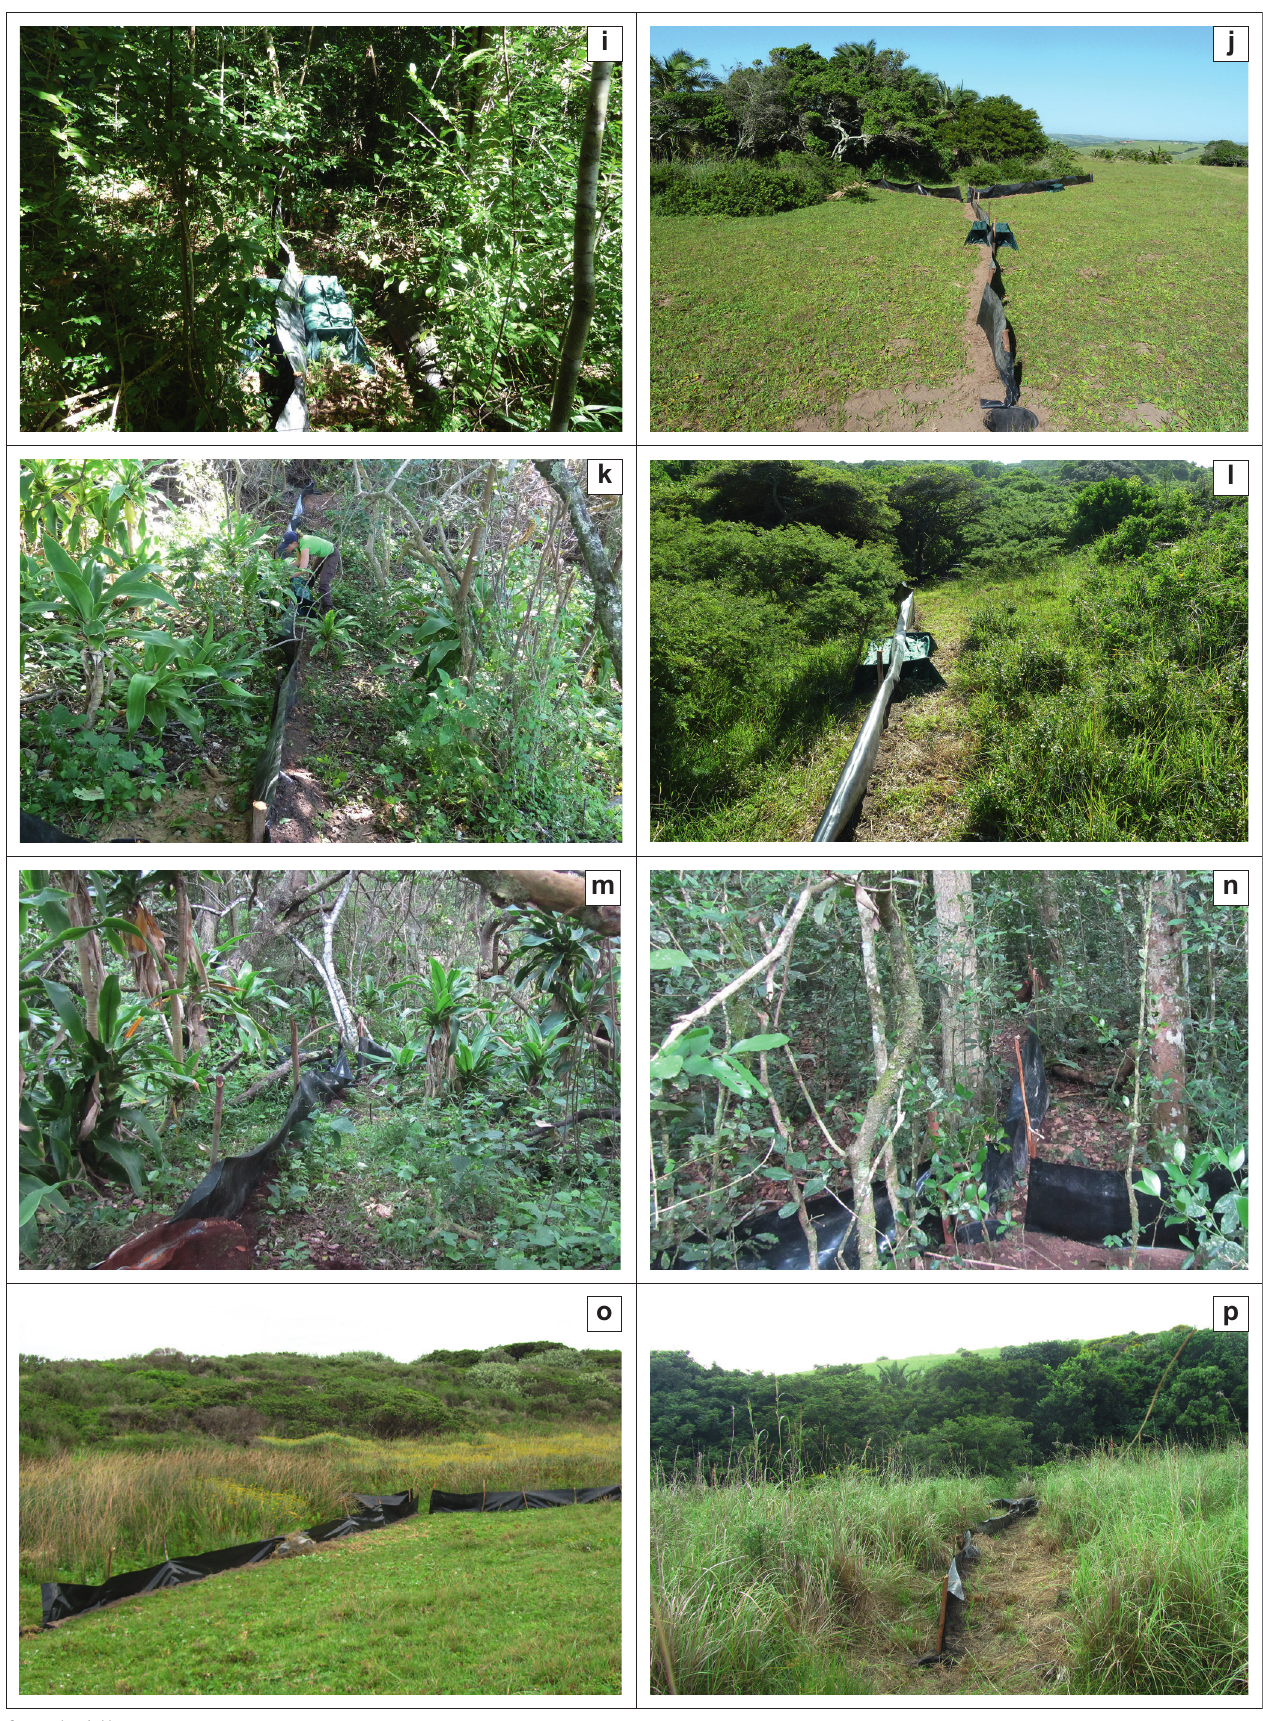
FIGURE 1-A4 (Continues...): (a–ai) Habitat type and trap layout of the respective trap sites surveyed during this study.